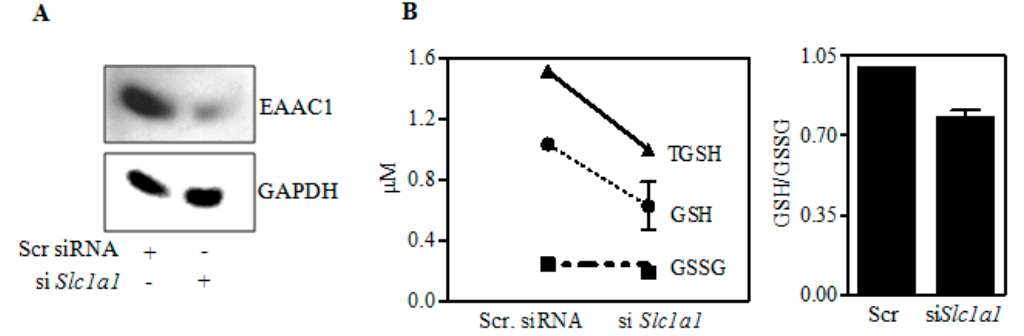
Figure 6. Effect of siRNA-mediated Slc1a1 knockdown on GSH and GSSG levels. PCNs were transfected with either nontargeting scramble siRNA or a SMARTpool mix of four si Slc1a1 using siPORT amine. 48 h post-transfection, protein extracts were immunoblot-analyzed for EAAC1 ( A ) ( n = 3); and fluorimetry-based determination of GSH and GSSG content ( B ). The bar graph represents the GSH/GSSG ratio with n = 2 pooled from 3 individual samples ( B ).